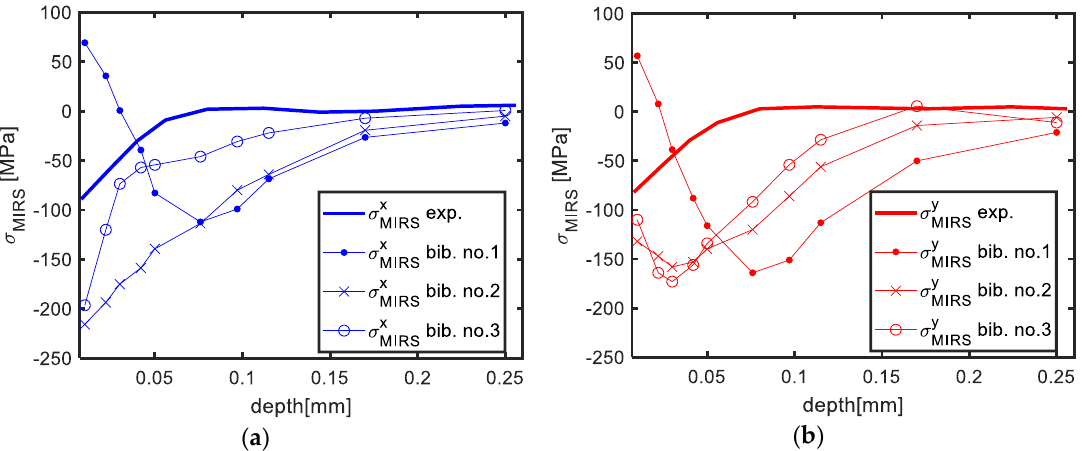
Figure 13. MIRS profiles in Al7050-T7451 blanks for different machining parameters: Experimental vs. results from bibliography [35] in X direction ( a ), and in Y direction ( b ).